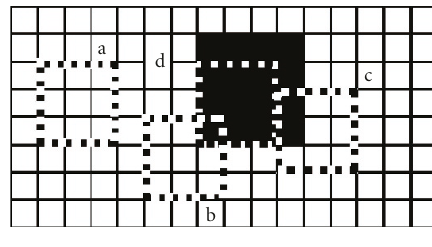
Figure 1: Various values of parameter p : (a) p = 0, (b) p = 1 / 9, (c) p = 2 / 9, (d) p = 1 (black pixels = deterministic region, white pixels =